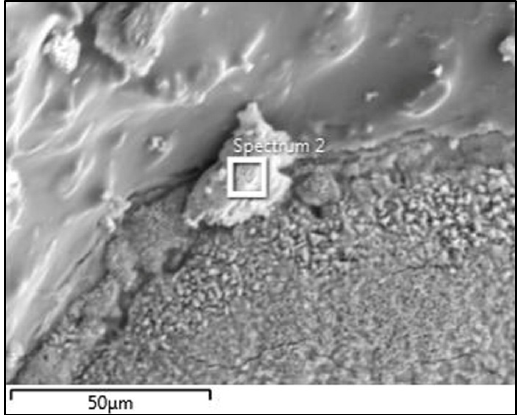
Figure 5. EDS analysis of chromium containing particle in Figure 2d.